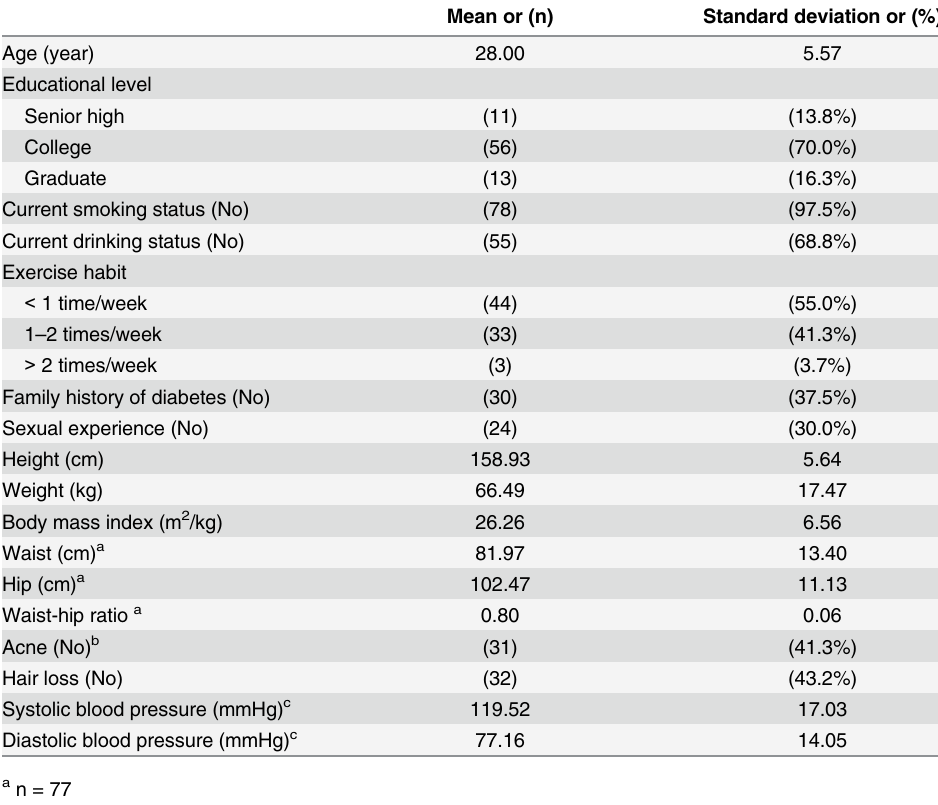
Table 1. Participants ’